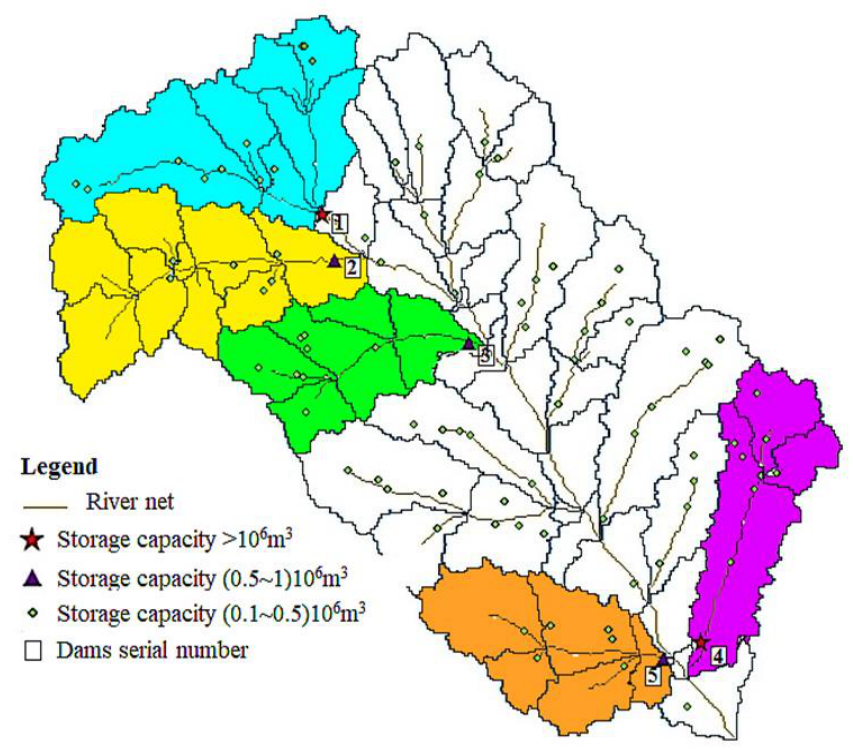
Figure 2. Distribution of select silt dams (storage capacity is > (0.1)10 6 m 3 ) in the Chabagou River Watershed. (The selected sub-watersheds controlled by five large-scale silt dams are marked by different colors). Table 1. General information of the five large-scale silt dams with storage capacity > (0.5)10 6 m 3 in the watershed.